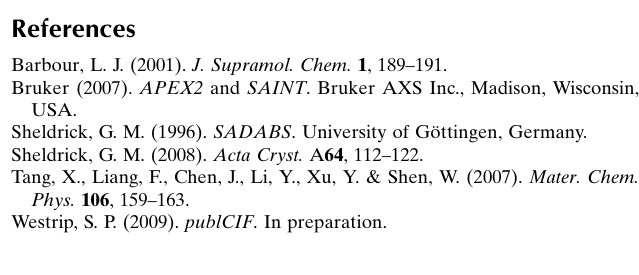
Experimental Crystal data